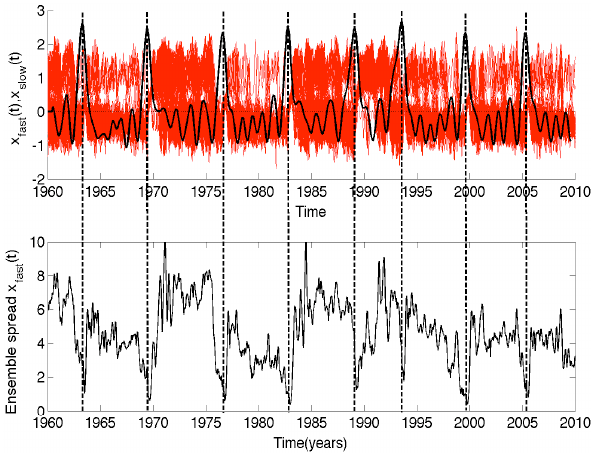
Fig. 6. Top: x a anomalies of ensemble members (red) and x o anomalies (black) time series. Bottom: Spread of x a ensemble